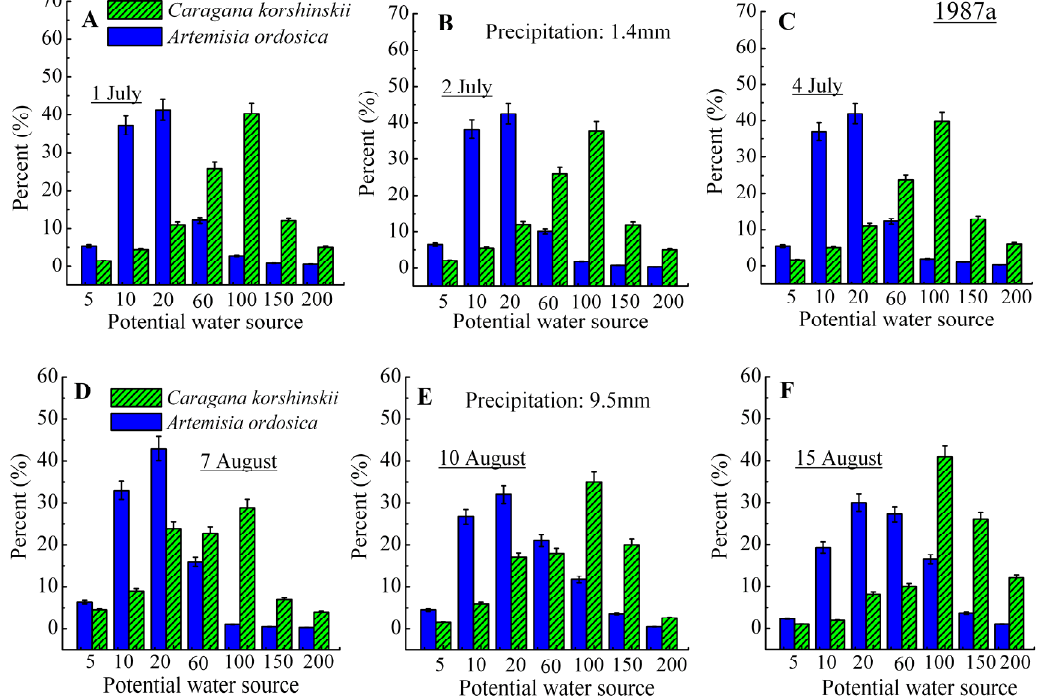
Figure A3. Proportion of potential water source for C. korshinskii and A. ordosica in 1987a revegetated site during a small precipitation event (1.4 mm; A – C ) and a large precipitation event (9.5 mm; D – F